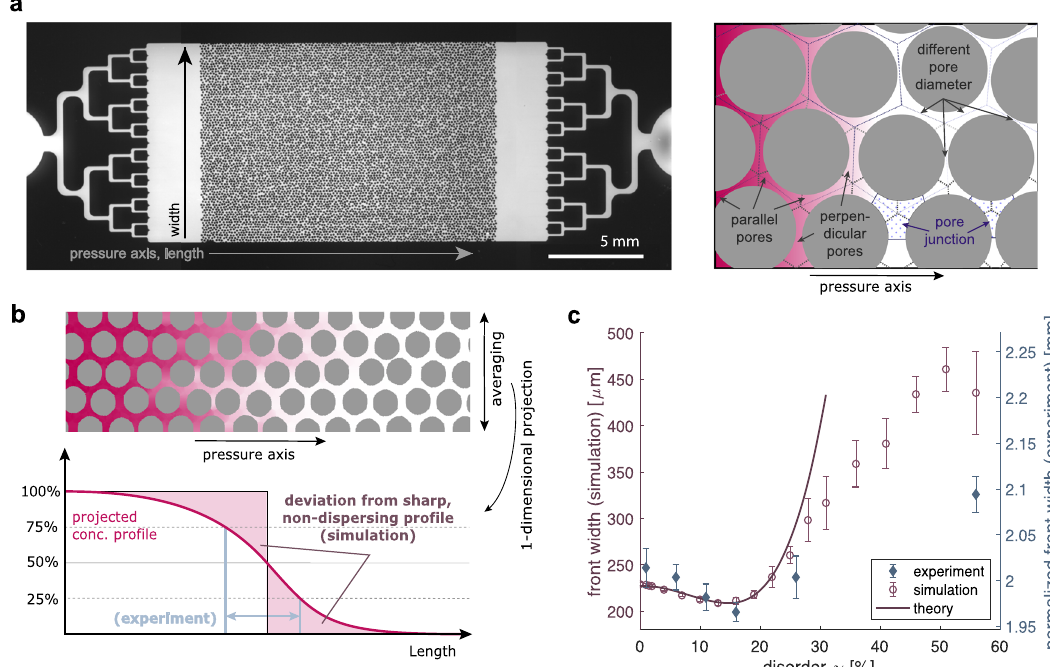
Fig. 1 | Pore-space heterogeneity affects transport dynamics. a Experimental setup.Atwo-dimensionalporousmediumisconstructedinsideamicro fl uidicchip. The effect of pore space heterogeneity on transport dynamics is investigated as a fl uorescentsolutetraversesthechip.Theinletdesignisoptimisedtocreateinitially sharpfronts.Parallelpores,perpendicularpores,andporejunctionsaredepictedin the cartoon to the right. b Measurement of the dispersive front width. Cartoon explaining the front width measures employed, see also ‘ Methods ’ . The con- centration pro fi les are averaged perpendicular to the pressure axis. The deviation from a step function measures the ef fi ciency of transport. The distance between relative solute concentrations of 25% and 75% is the experimental measure for the front width. Each experimental run is corrected for an offset caused by diffusive spreadinginthetubing.Theaverageoffsetisaddedasaconstanttomatchwiththe